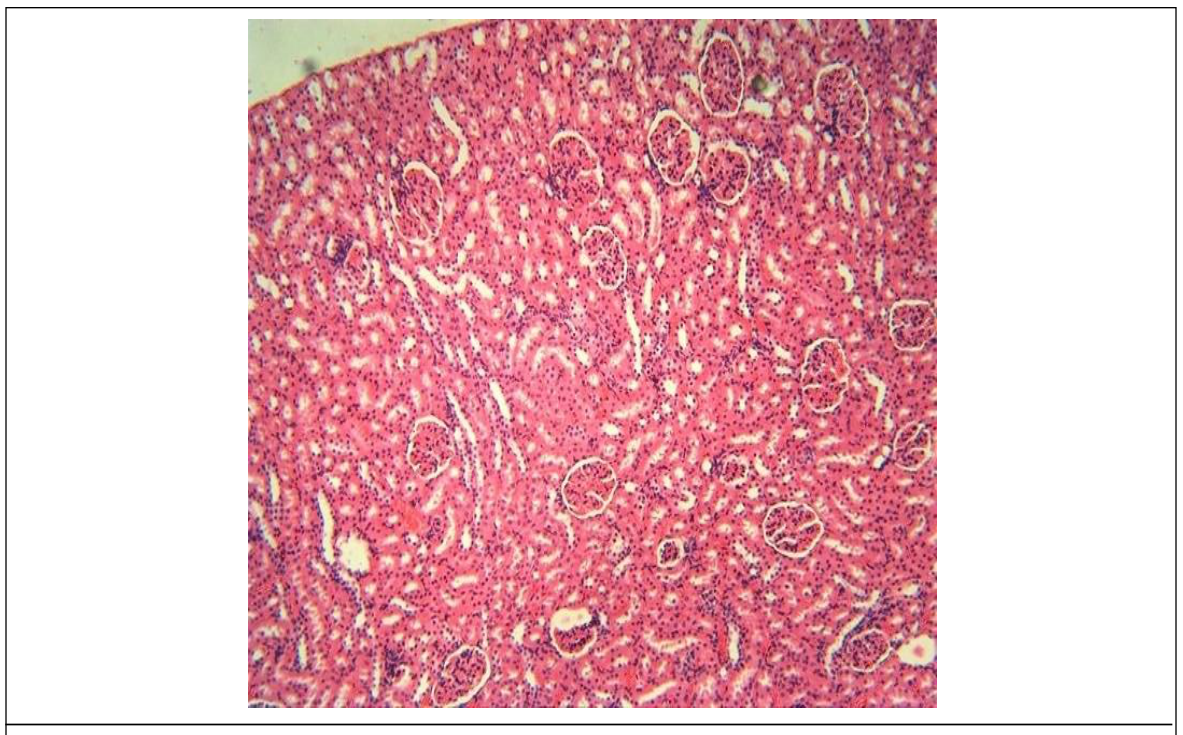
Photomicrographs of the kidney section of group D or normal control rats administered with feed and water only showed normal kidney architecture, normal glomerular size of up to 17 per HPF with normal mesangial cellularity and stroma, presence of distal and proximal tubules and normal size nuclei (Mg. X400).